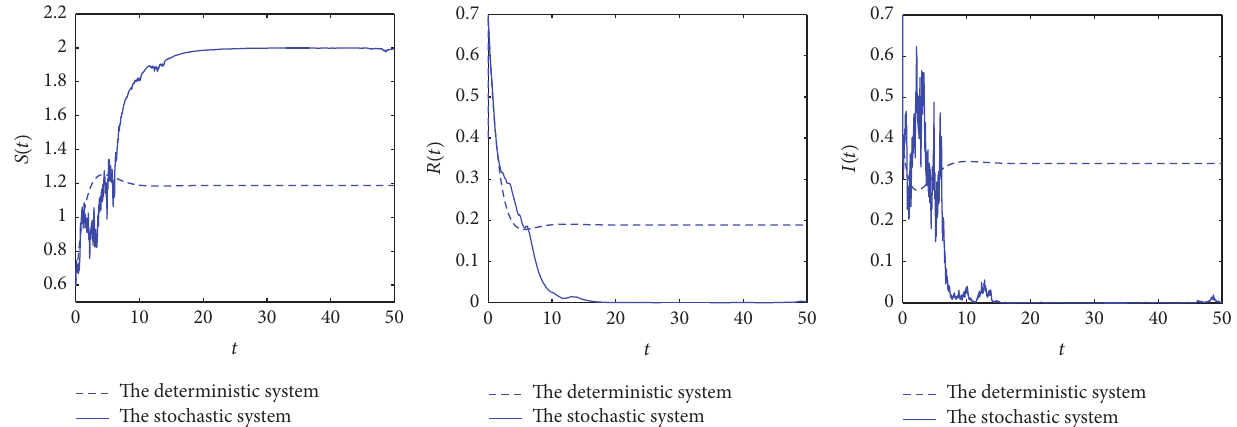
Figure 1: Simulations of the path (𝑆(𝑡),𝐼(𝑡),𝑅(𝑡)) for the corresponding deterministic system (2) and stochastic system (4) with initial value (𝑆(0),𝐼(0), 𝑅(0)) = (0.6, 0.4, 0.5) , 𝜎 = 0.5 .